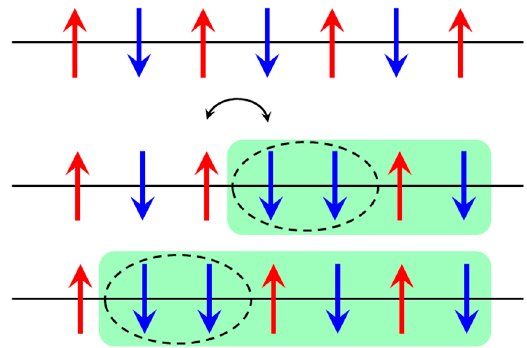
Figure 1. Schematic representation of a spinon excitation by reversing all spins beyond a certain lattice site. The spinon (domain wall) propagates along the chain moving by two lattice sites.